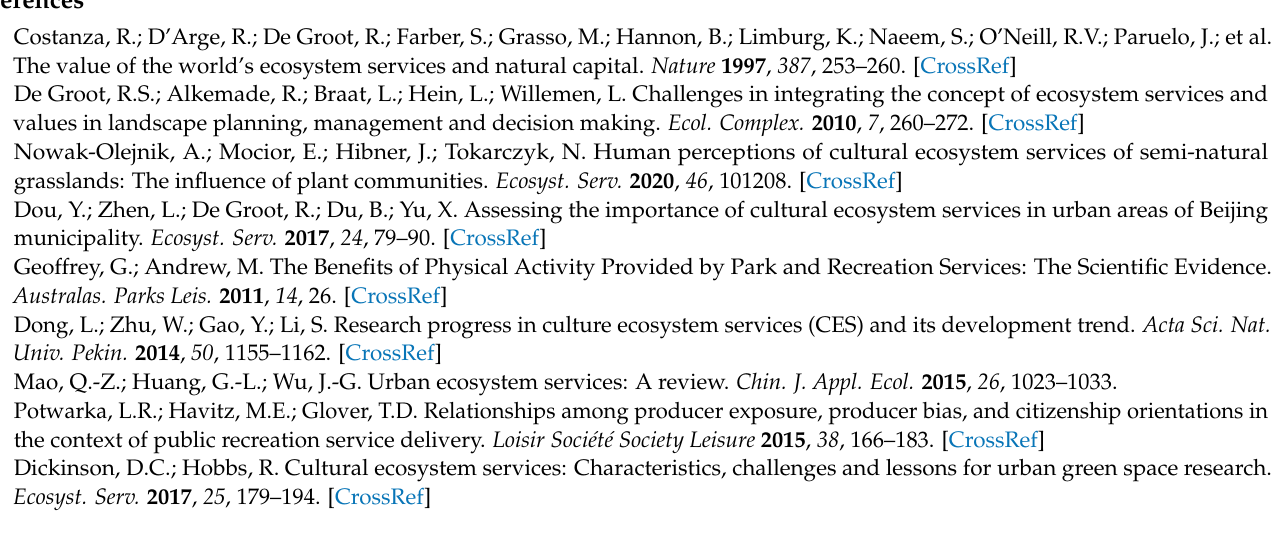
TGRA; Figure S2: Average (a) and the modeled slope (b) of the recreation-service proxy between 2000 and 2015 at the county scale; Figure S3: Heat map of the correlation matrix and hierarchical clustering for 20 counties in the TGRA according to the recreation service between 2000 and 2015; Figure S4: Temporal variations of the recreation-service proxy for different land-use-change types of the